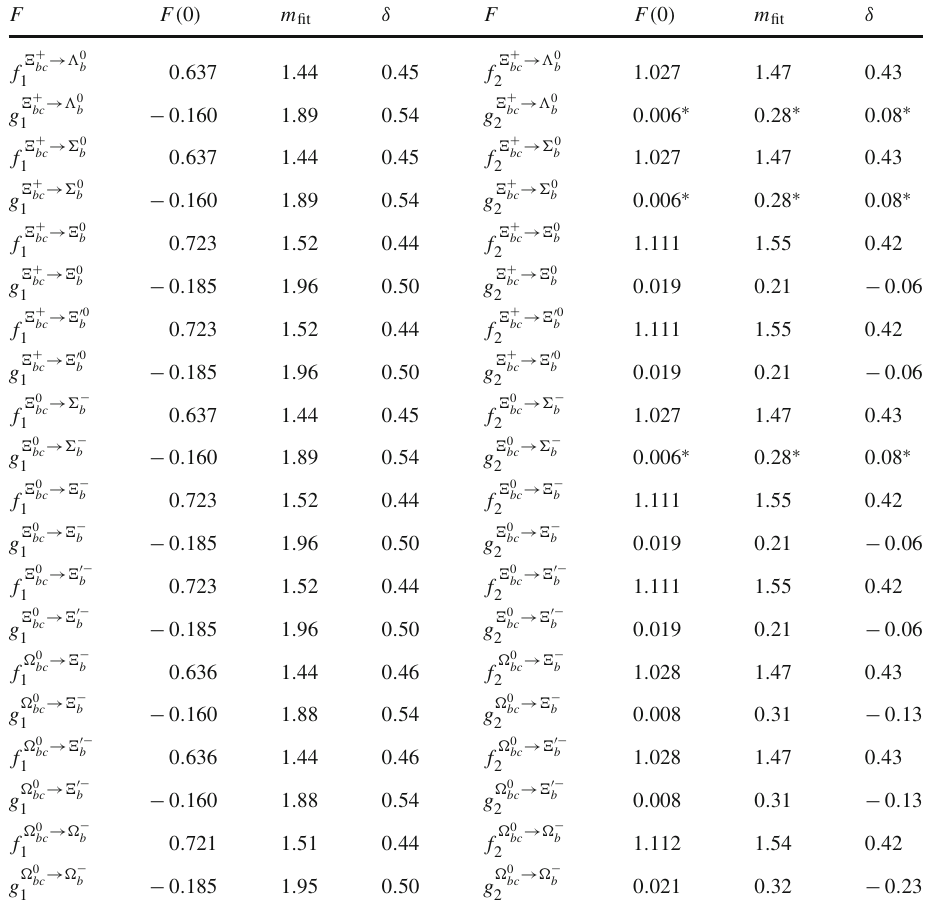
Table 13 Same as Table 9 but for the charm decays of bottom–charm baryons with axial vector ( 1 + )